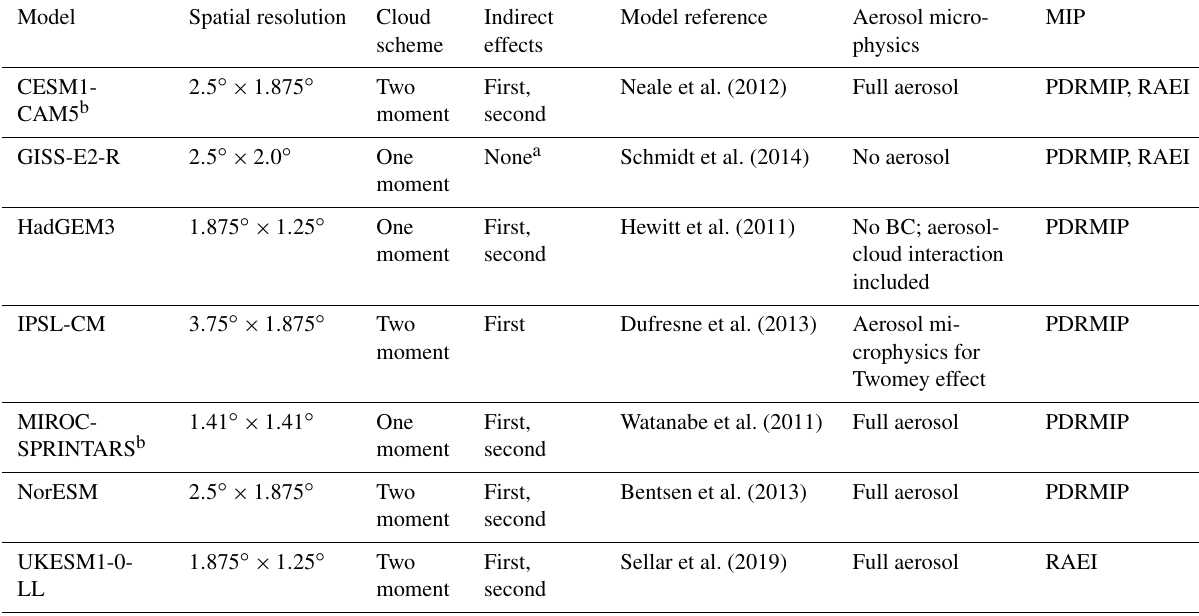
Table 1. Details of the models analyzed in this work. For the models participating in the PDRMIP Asian aerosol perturbation simulations, each simulation lasts 100 years. Cloud scheme refers to the microphysical cloud scheme that describes cloud formation, where a one-moment scheme considers only changes in mass and a two-moment scheme considers changes in mass and number concentration. The first indirect effect refers to the aerosol effect on cloud albedo, and the second indirect effect refers to the aerosol effect on cloud